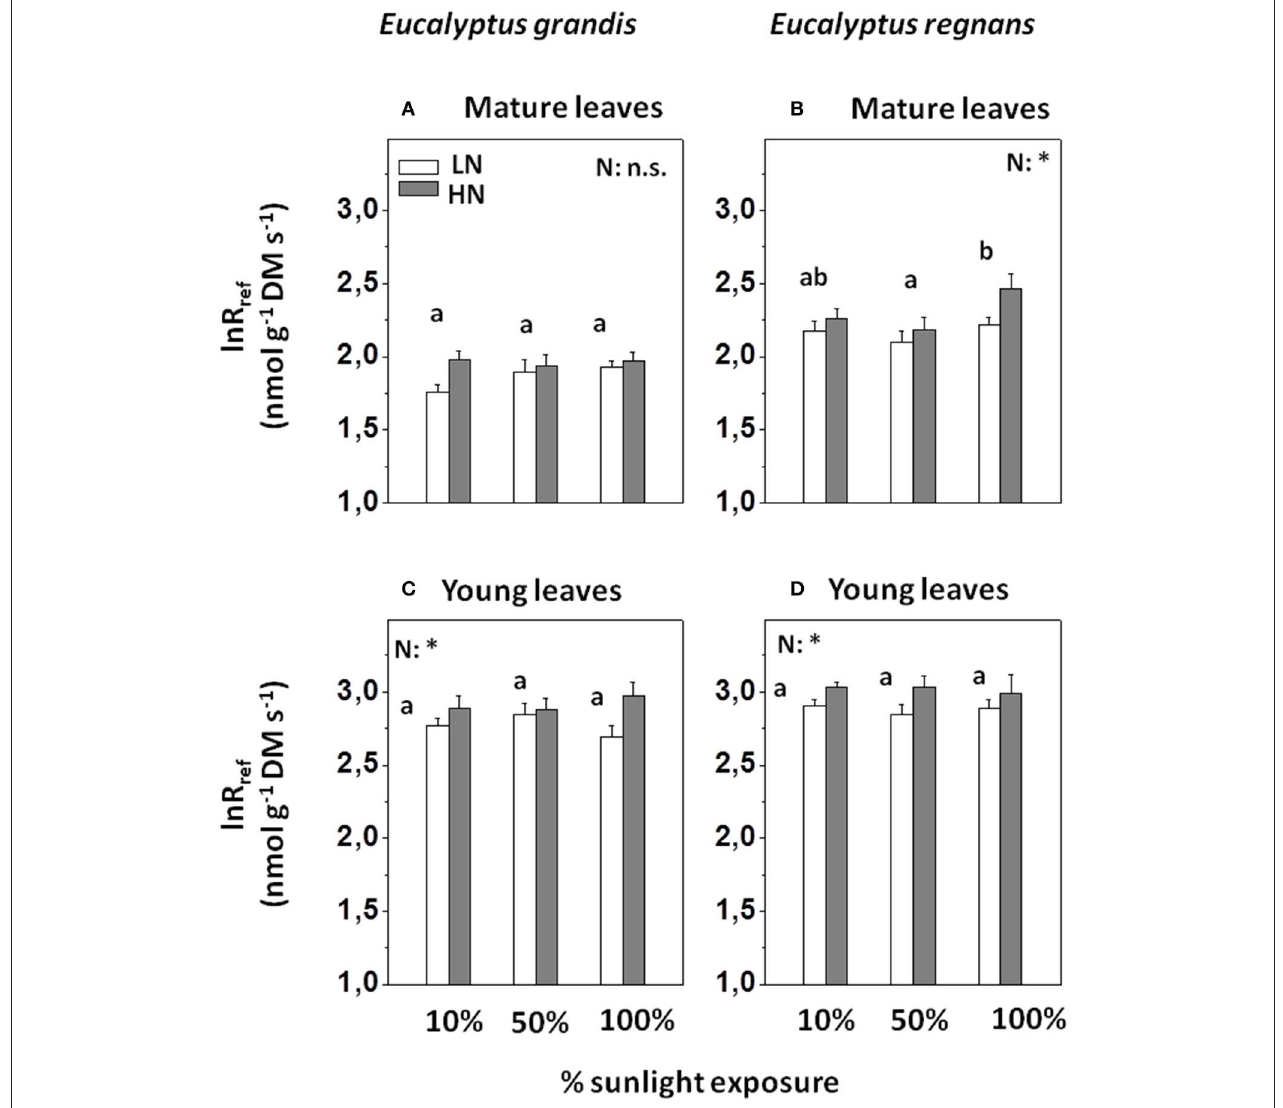
FIGURE 5 | Capacity of mitochondrial O 2 -reduction in Eucalyptus grown under differing N-nutrition and light intensity, as determined via Calorimetry. (A) Capacity of respiratory O 2 -reduction (i.e., lnR ref ; logarithmic rates of O 2 -reduction at 15 ◦ C reference temperature) in mature Eucalyptus grandis leaves. (B) Respiratory capacity in mature Eucalyptus regnans leaves. (C) Respiratory capacity in young Eucalyptus grandis leaves. (D) Respiratory capacity in young Eucalyptus regnans leaves. Open columns: “low” N-supply (LN: 2.6mM N). Gray columns: “high” N-supply (HN: 8mM N). Each column shows the average ± SE of six independent replicates. Different letters indicate significant differences between light regimes within species ( N = 12 for each factor group; post-hoc Tukey HSD- test). Asterisk (*) indicates significant N-treatment effect ( N = 18 for each factor group; n.s., not significant). N × L interactions within species were not significant. For effect sizes between species and treatments (and leaf developmental stage), see Table 3